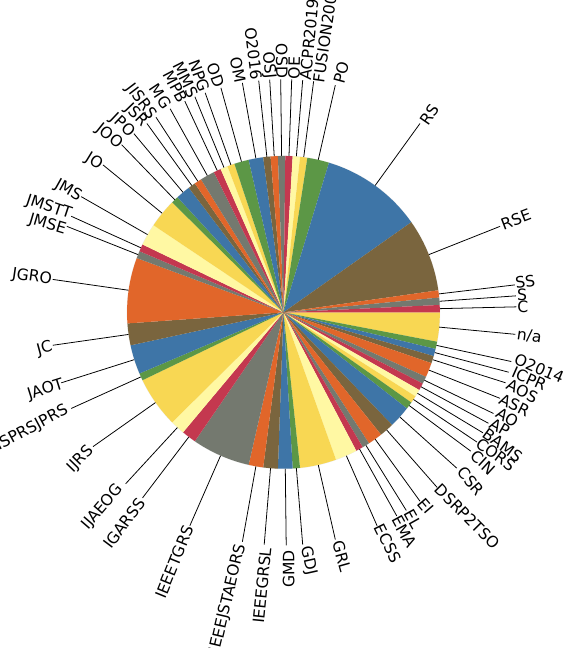
Figure A1. Representation statistics regarding publishing journals of the surveyed articles. List